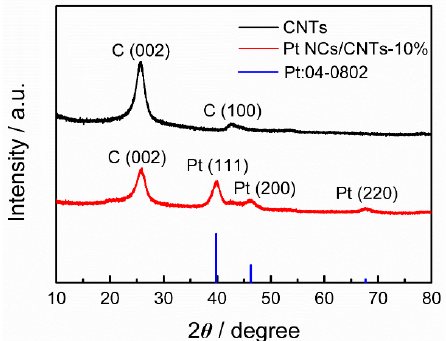
Figure 1. X-ray diffraction (XRD) patterns of the carbon nanotubes (CNTs), Pt NCs/CNTs-10%, and standard bulk Pt.